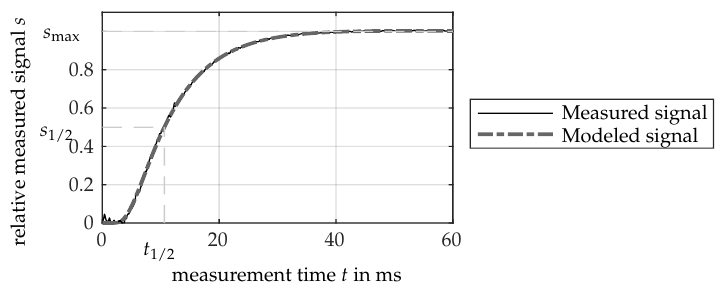
Figure 5. Exemplary measurement signal of material M1 at 348K.